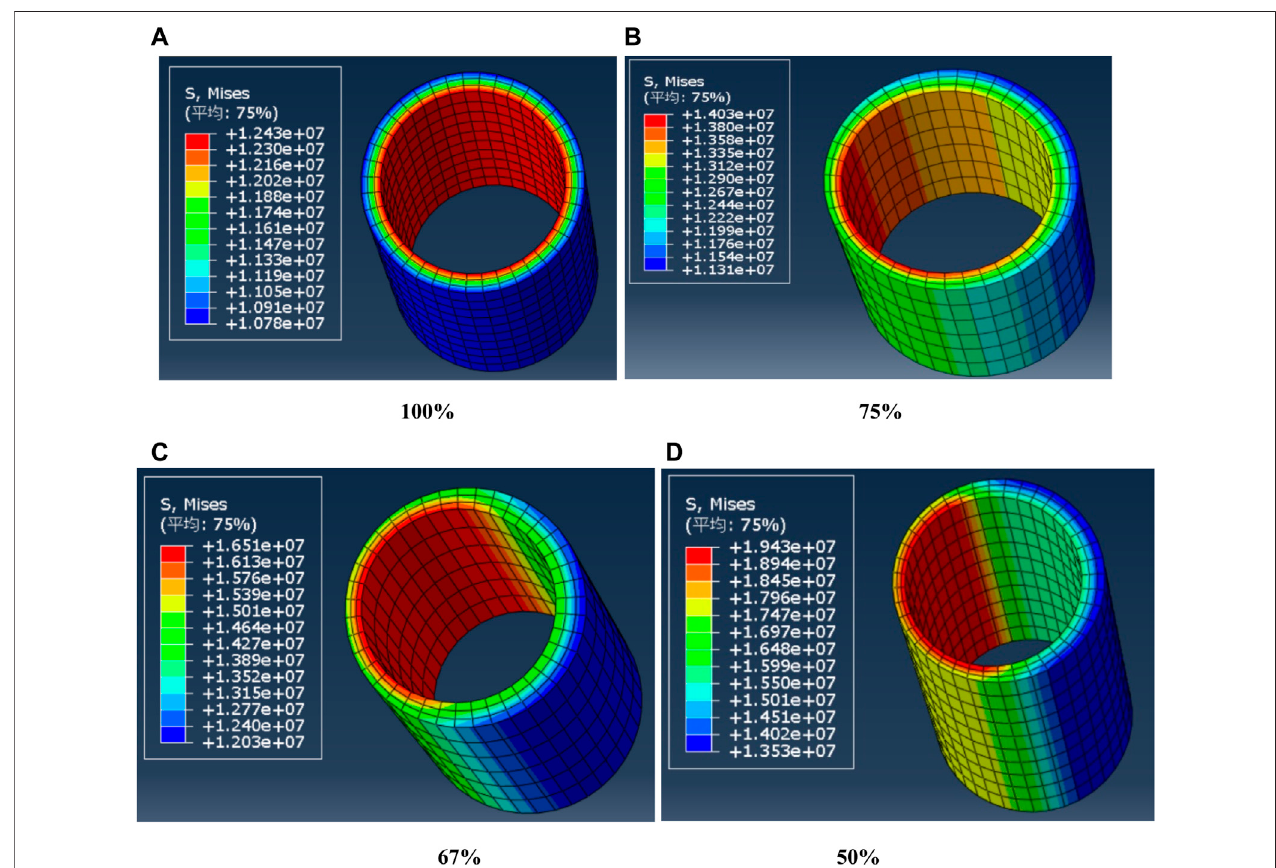
FIGURE 5 | stress distribution under different conditions.